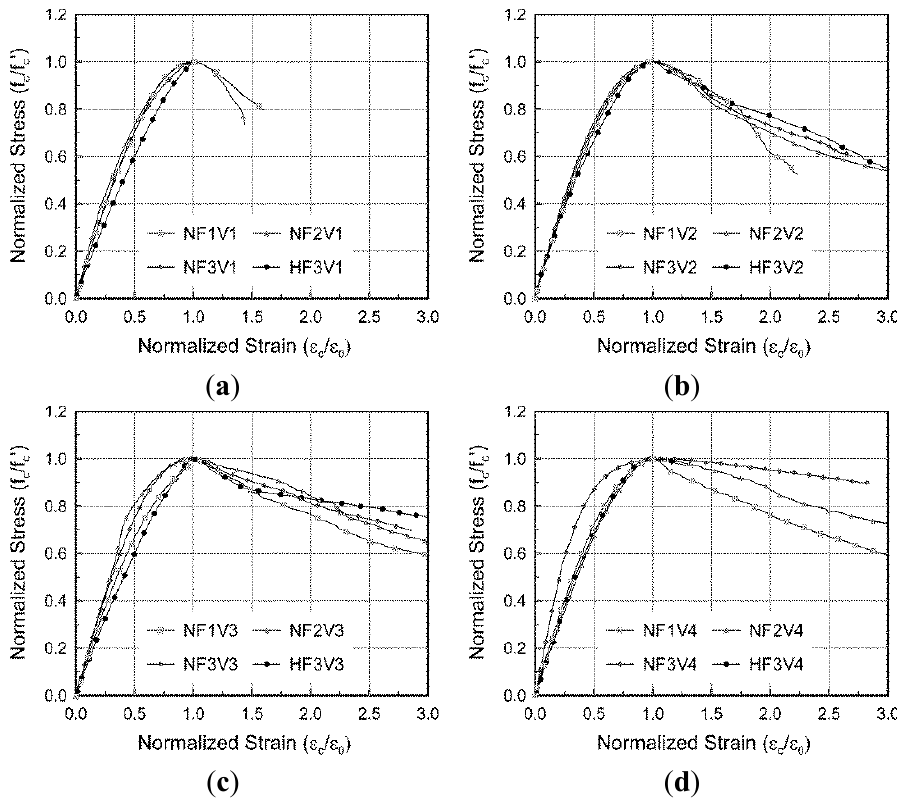
Figure 6. Effect of fiber aspect ratio on the stress-strain response under